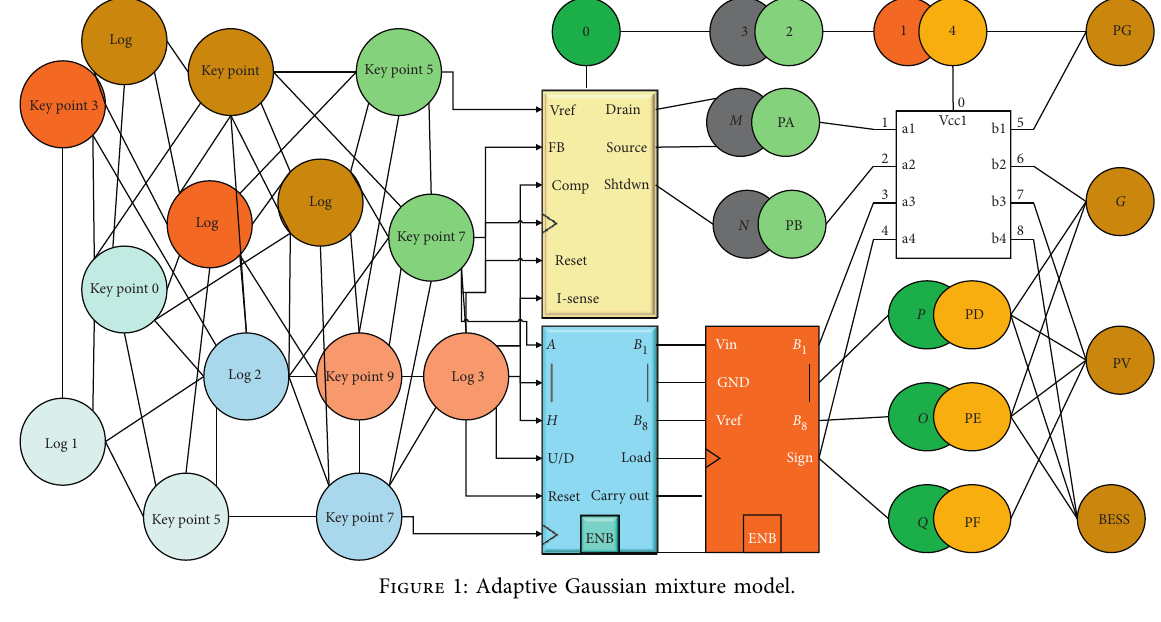
Figure 1: Adaptive Gaussian mixture